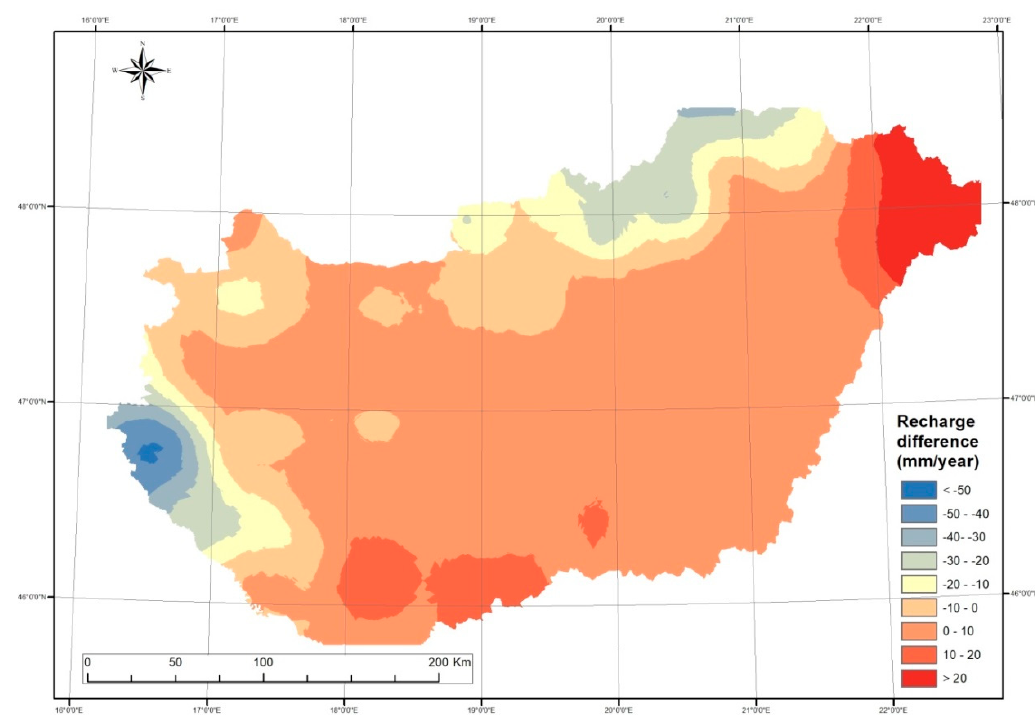
Figure 9. Simulated difference in groundwater recharge between 2005–2009 and 1961–1965 averages based on CAR- PATCLIM data.